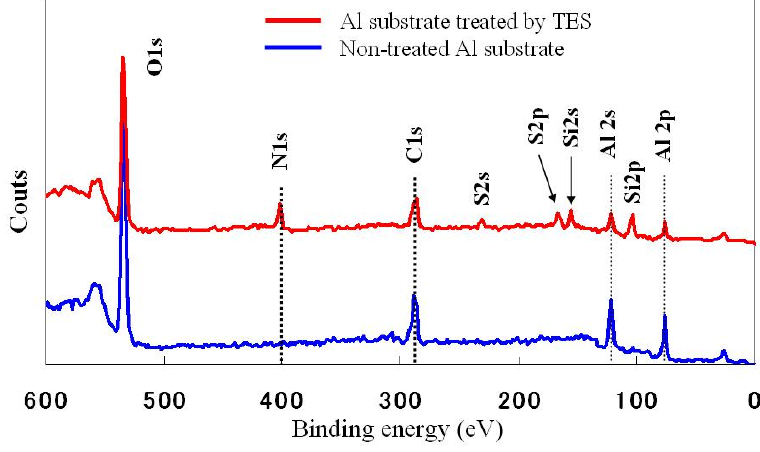
Figure 3. XPS wide scan spectra of the untreated and TES treated aluminum surfaces in 45 tilt degree. (X-ray anode: Al monochromated 2 nm filament; Aperture: 800 × 200 μ m).